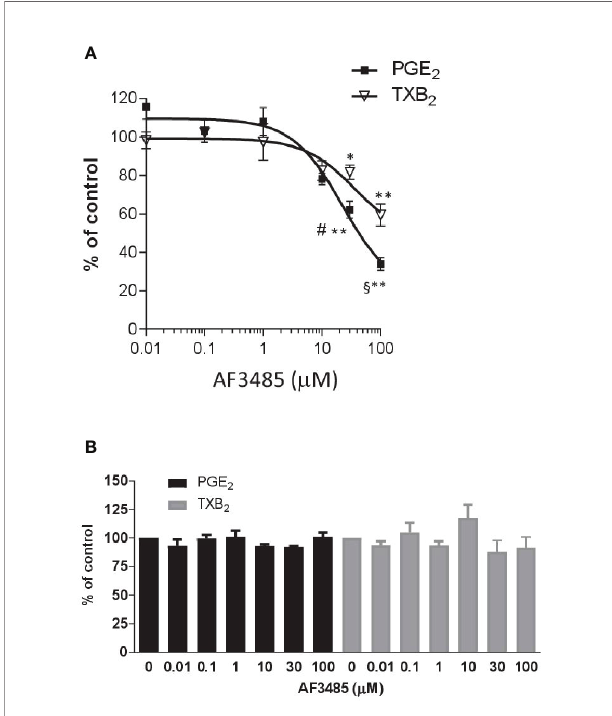
FIGURE 1 | Effects of AF3485 on prostanoid production in human LPS- or thrombin-stimulated whole blood. (A) Increasing concentrations of AF3485 (0.01 – 100 µM) or DMSO vehicle were incubated with 1 ml of heparinized human whole blood stimulated with LPS (10 µg/ml) for 24 h. PGE 2 and TXB 2 were assessed by immunoassays. Results were reported as % of control (DMSO vehicle) (mean ± SEM, n = 4-5). **P < 0.01, *P < 0.05 versus vehicle (DMSO). # P < 0.05, § P < 0.01, PGE 2 versus TXB 2 (Student's t-test). (B) AF3485 (0.01 µM – 100 µM) or DMSO vehicle was incubated with 1 ml of whole blood samples that were allowed to clot for 60 min at 37°C. PGE 2 and TXB 2 levels were measured. Results are reported as % of control (DMSO vehicle) (mean ± SEM, n = 3-4)(One-way ANOVA). LPS, Lipopolysaccharide; PGE 2 , prostaglandin E